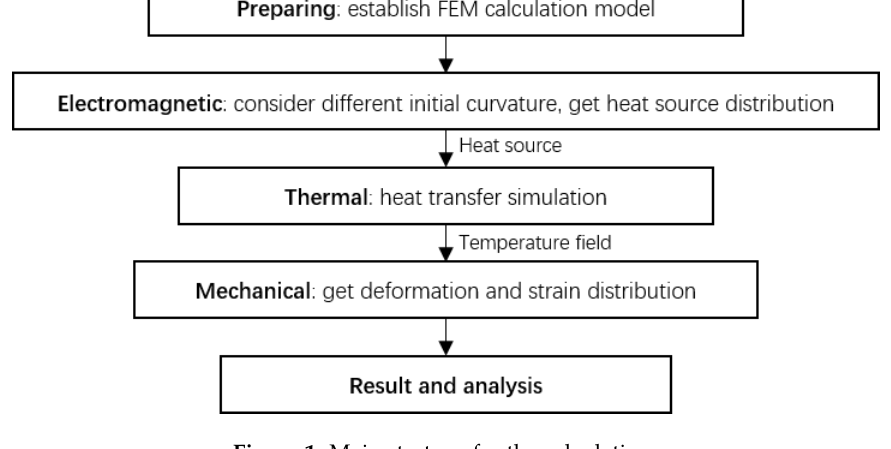
Figure 1. Main strategy for the calculation.